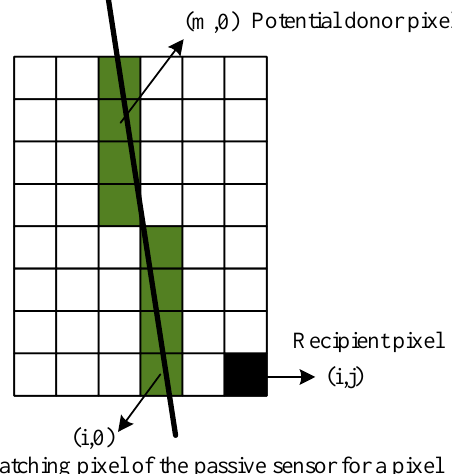
Figure 6. Relationship of relative pixels.